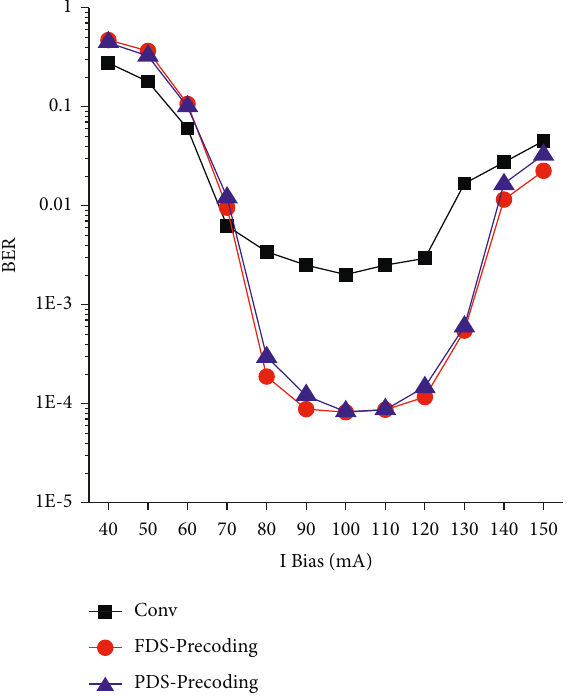
Figure 8: The BER performances versus I Bias for different DMT